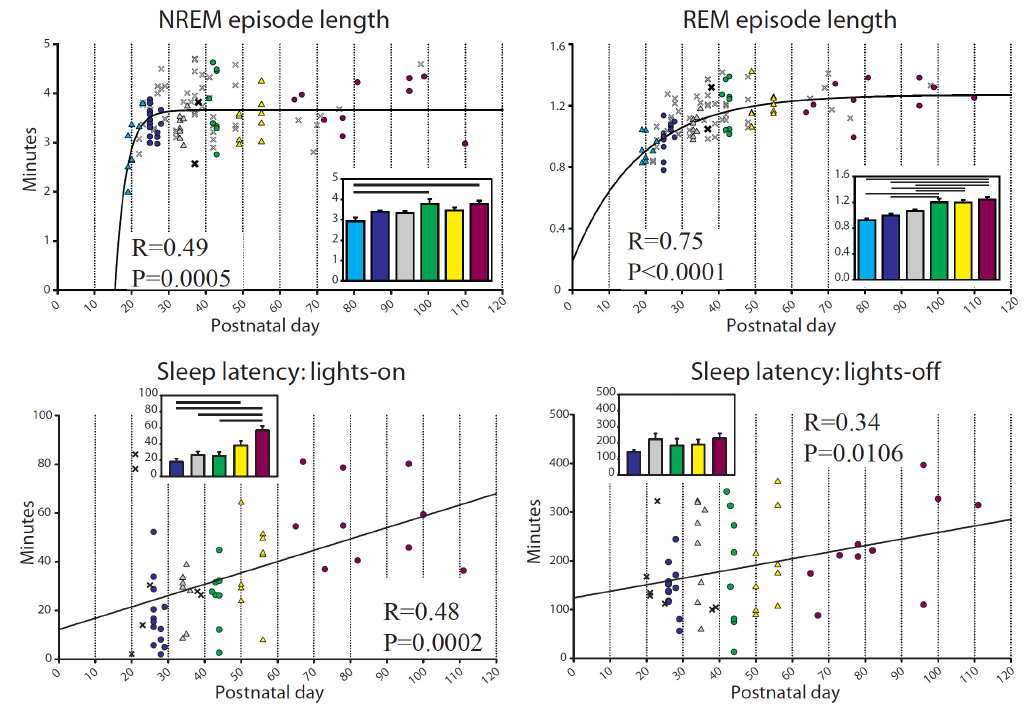
Figure 3. Episode duration and sleep latency during baseline. For episode length, p and R are from the regression for an exponential equation increasing to a maximum, f = y + a × [1 − exp( − b × x )] (top left: f = min, y = − 407.10, a = 410.67, b = 0.32, 0 0 x = Postnatal day), (top right: f = min, y = 0.19, a = 1.08, b = 0.054, x = Postnatal day); for 0 + a × x ) (bottom left: sleep latency, p and R are from the linear regression ( f = y 0 f = min, y = 12.12, a = 0.47, x = Postnatal day; bottom right: f = min, y = 120.45, 0 0 a = 1.41, x = Postnatal